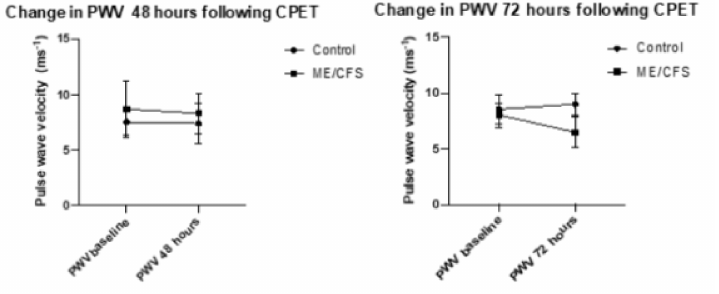
Figure 2. Change in PWV at 48 and 72 h following